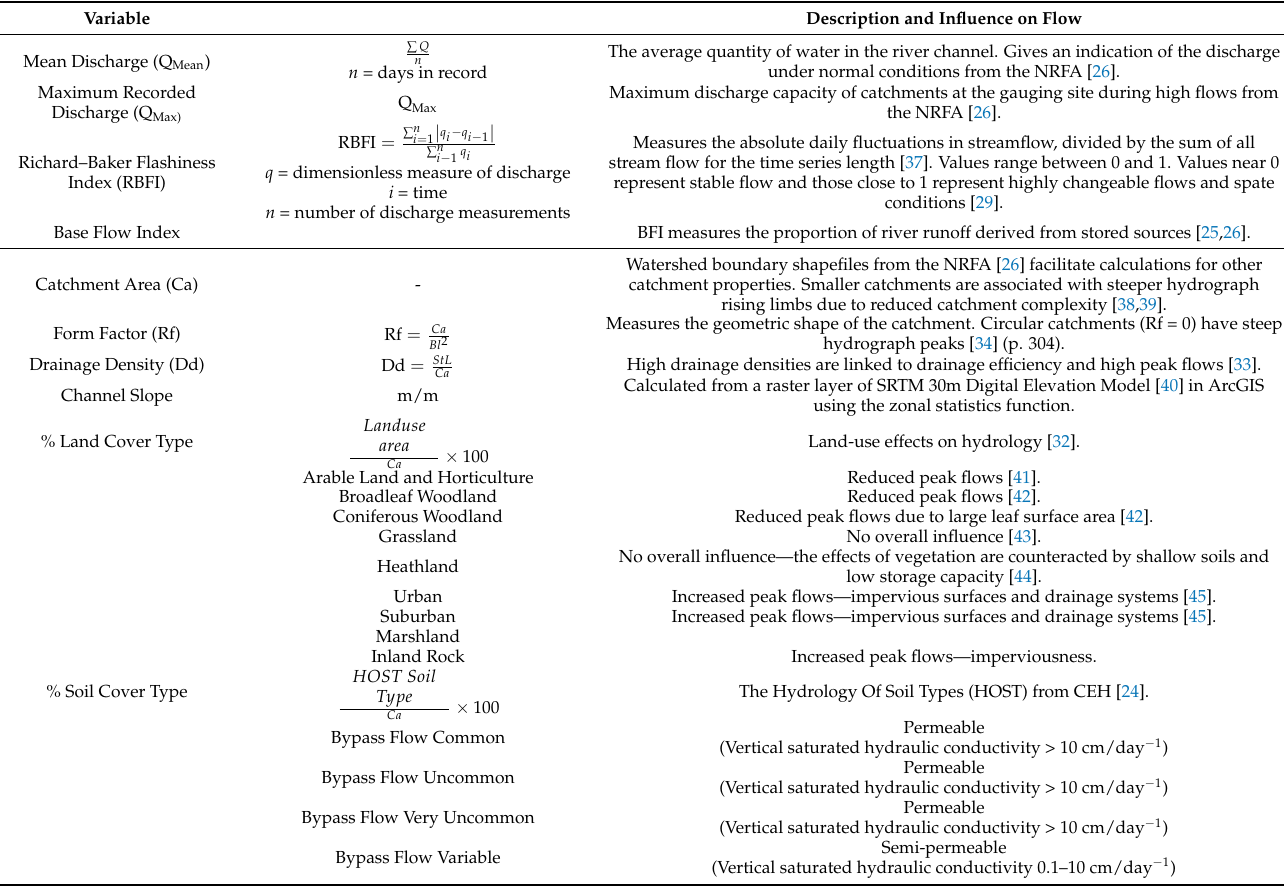
Table 1. Equations and methodology of variables compiled for the response and explanatory databases for the redundancy